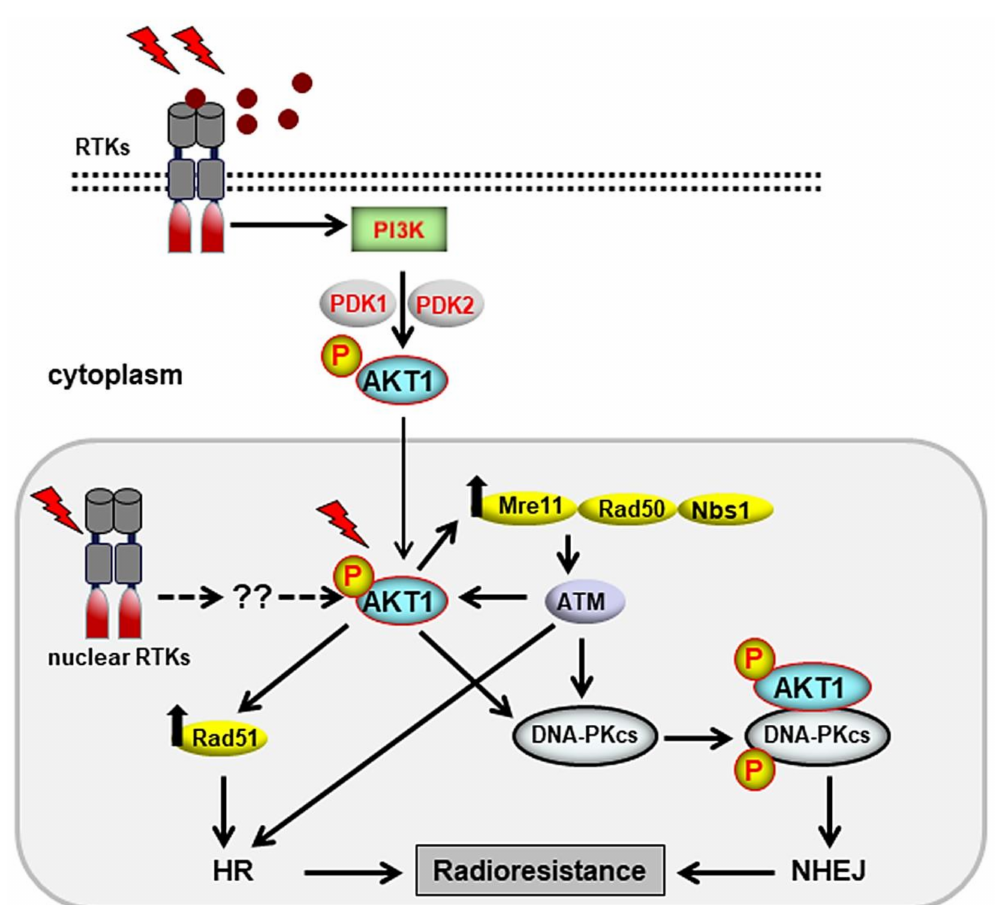
Figure 3. AKT1 stimulates DSB repair through the NHEJ and HR repair pathways. Exposure to IR induces the activation of cytoplasmic AKT1 that may translocate to the nucleus. Alternatively, IR can activate AKT1 by stimulating nuclear receptor tyrosine kinases (RTKs) independent of cytoplasmic AKT1. Activated AKT1 in the nucleus stimulates the DNA repair machinery by increasing the expression of repair proteins such as Mre11 and Rad51 or inducing the phosphorylation/activation of proteins involved in DDR and DSB